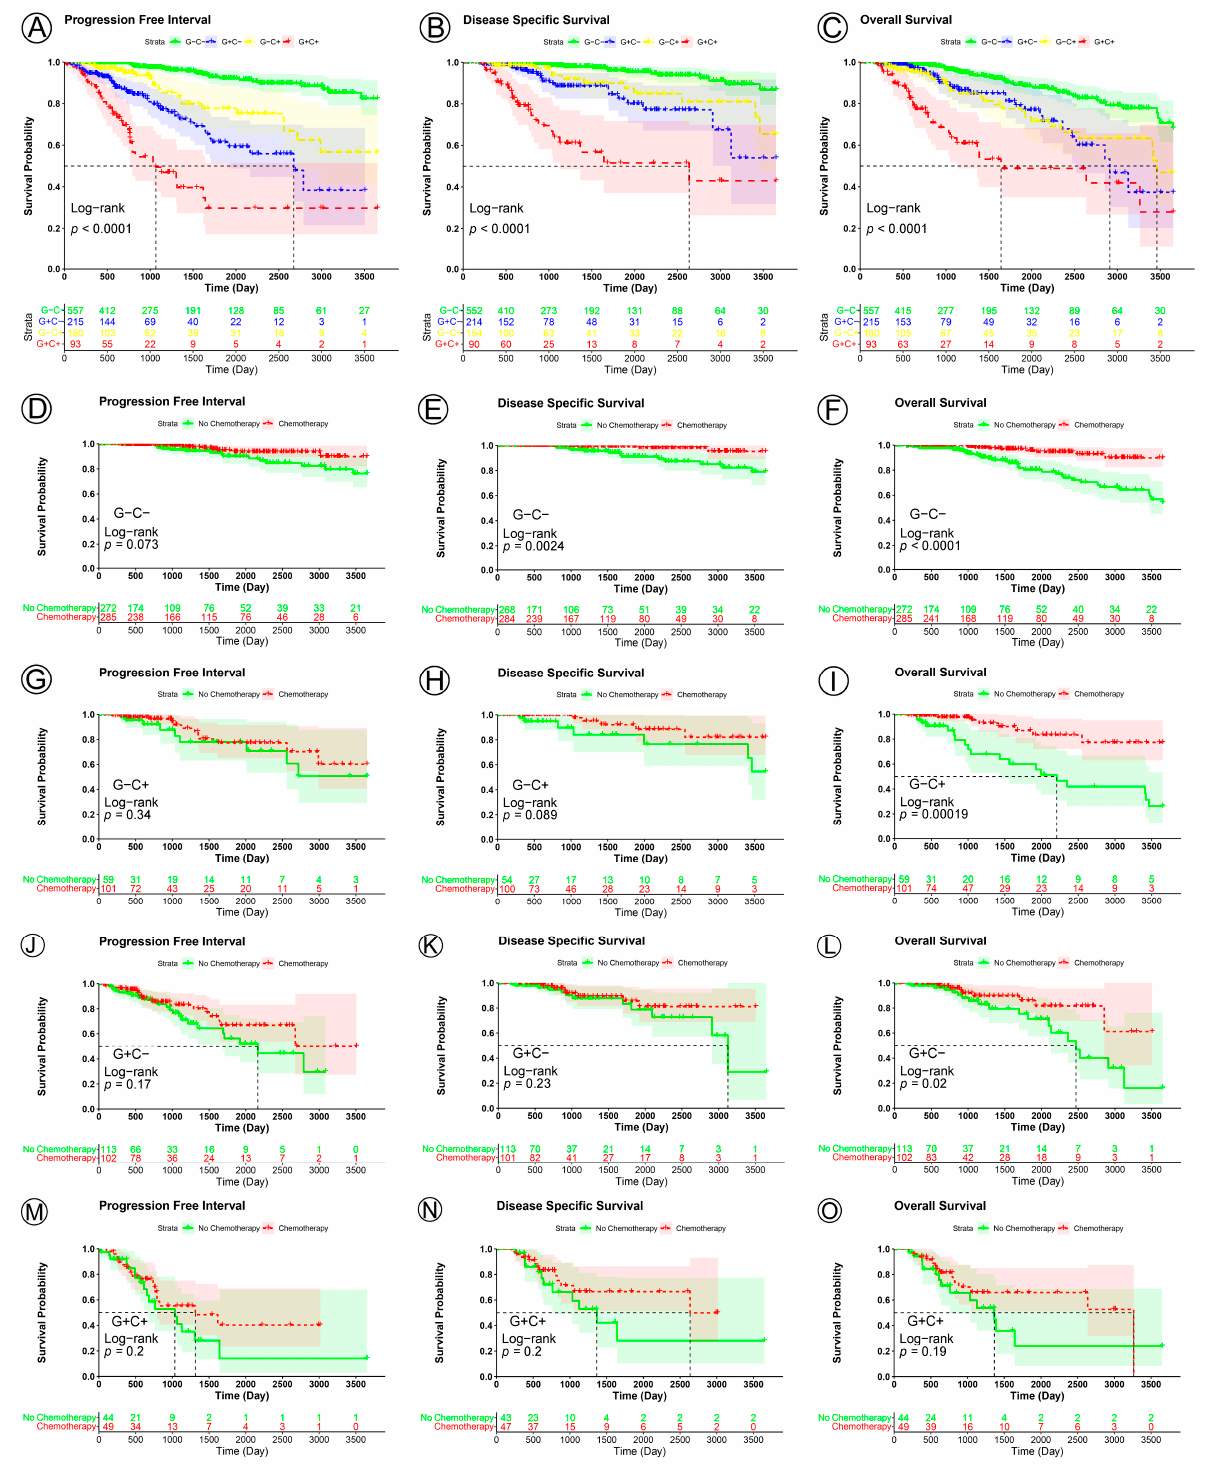
Figure 9. KM curve analyses of patients stratified by four risk subgroups (prognostic signature and clinical risk subgroups). ( A – C ), KM curves of PFI, DSS, and OS for breast cancer in the four risk subgroups (G-C-, G-C+, G+C-, and G+C+ subgroups). KM curves of PFI, DSS, and OS for breast cancer in G-C- ( D – F ), G-C+ ( G – I ), G+C- ( J – L ), and G+C+ ( M – O ) subgroups.